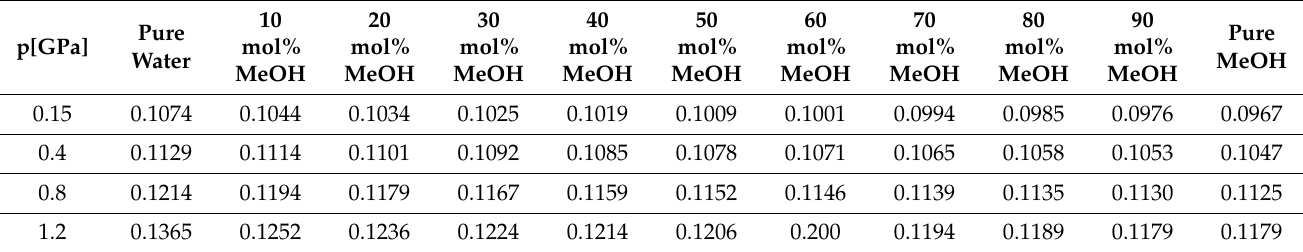
Table 1. Atomic number densities, in units of Å − 3 , of methanol–water mixtures as a function of pressures at room temperature, as obtained from NpT molecular dynamics simulations with the TIP4P/2005 [12] water potential (MeOH: methanol). (Note that similar MD simulations have been conducted with the SPC/E [15] water model, as well, from which nearly identical density values were